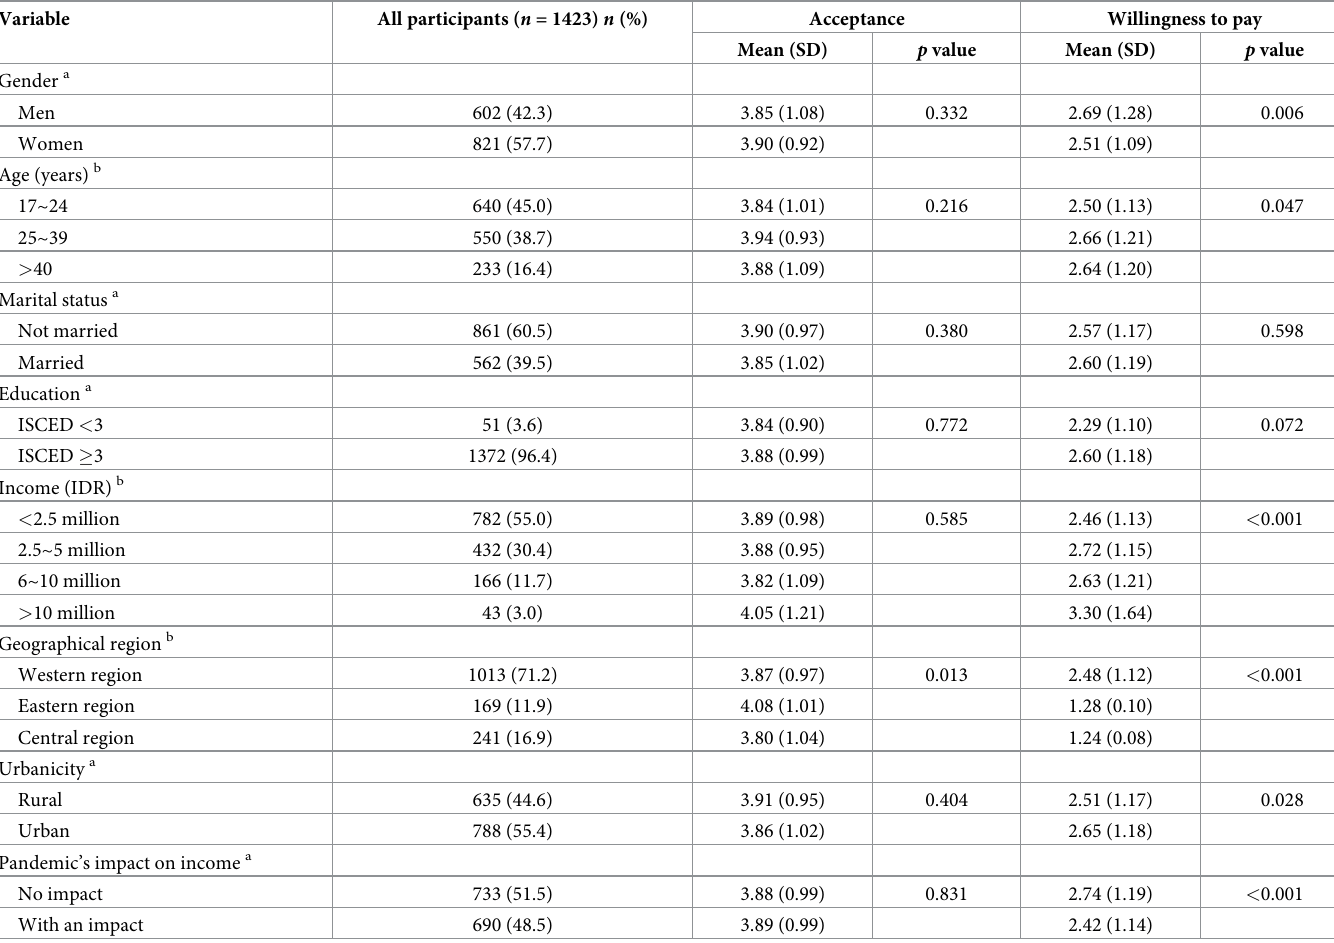
Data are presented as the mean ± standard deviation (SD), or frequency and percentage. COVID-19 = coronavirus disease 2019, ISCED = international standard classification of education; IDR = Indonesian rupiah.